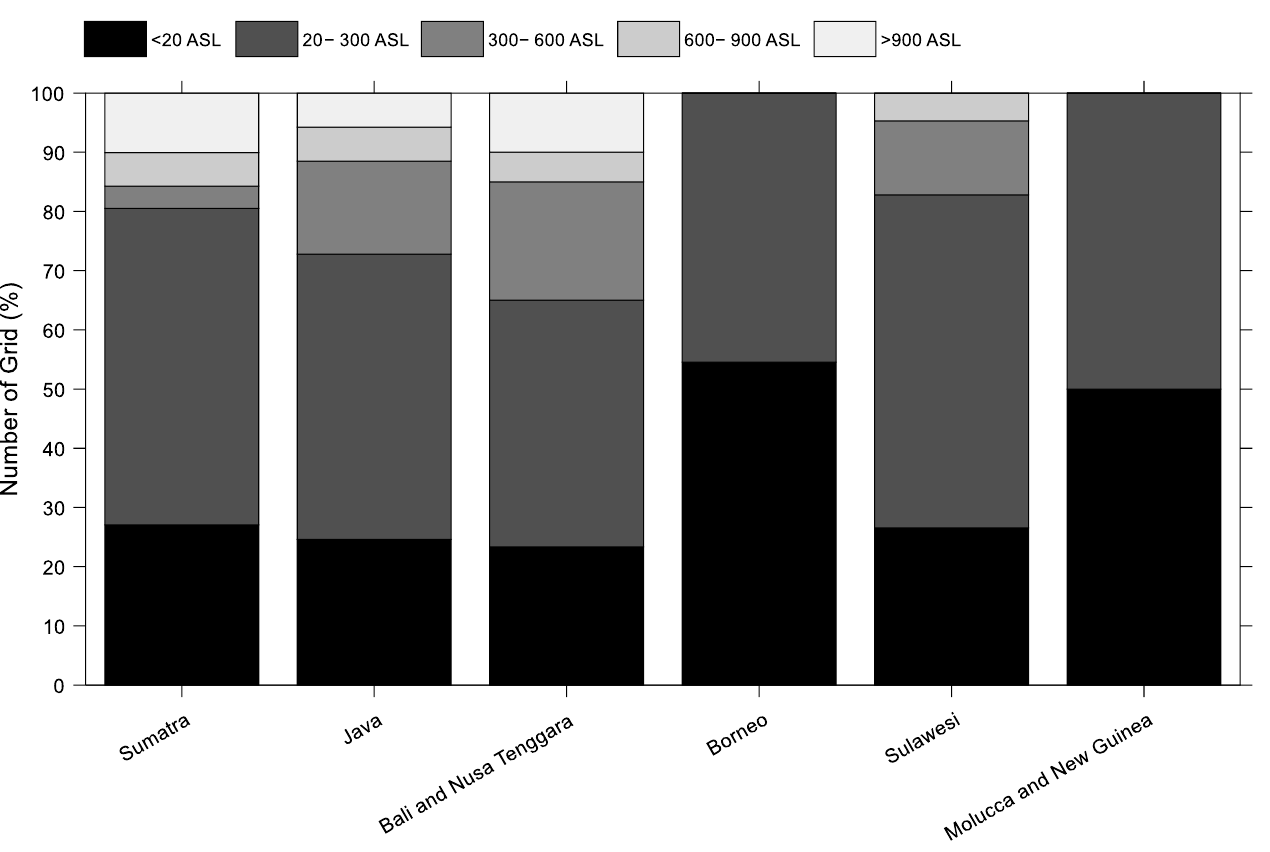
Figure 11. Percentage of grid numbers for the five altitude categories for each island. To evaluate the effect of elevation on the accuracy of GSMaP data, we fit each statistical test parameter to altitude. Statistical parameters were averaged for every 50 m ASL elevation. The results of linear fitting of each statistical parameter can be seen in Figure 12. The largest correlation value was observed in real-time GSMaP data, with a negative value (Table 9). This indicates a more significant elevation dependence of real-time GSMaP data compared to near-real-time and post-real-time GSMaP types. A decrease in CC values with increasing altitude was also found for IMERG data at IMC [43].